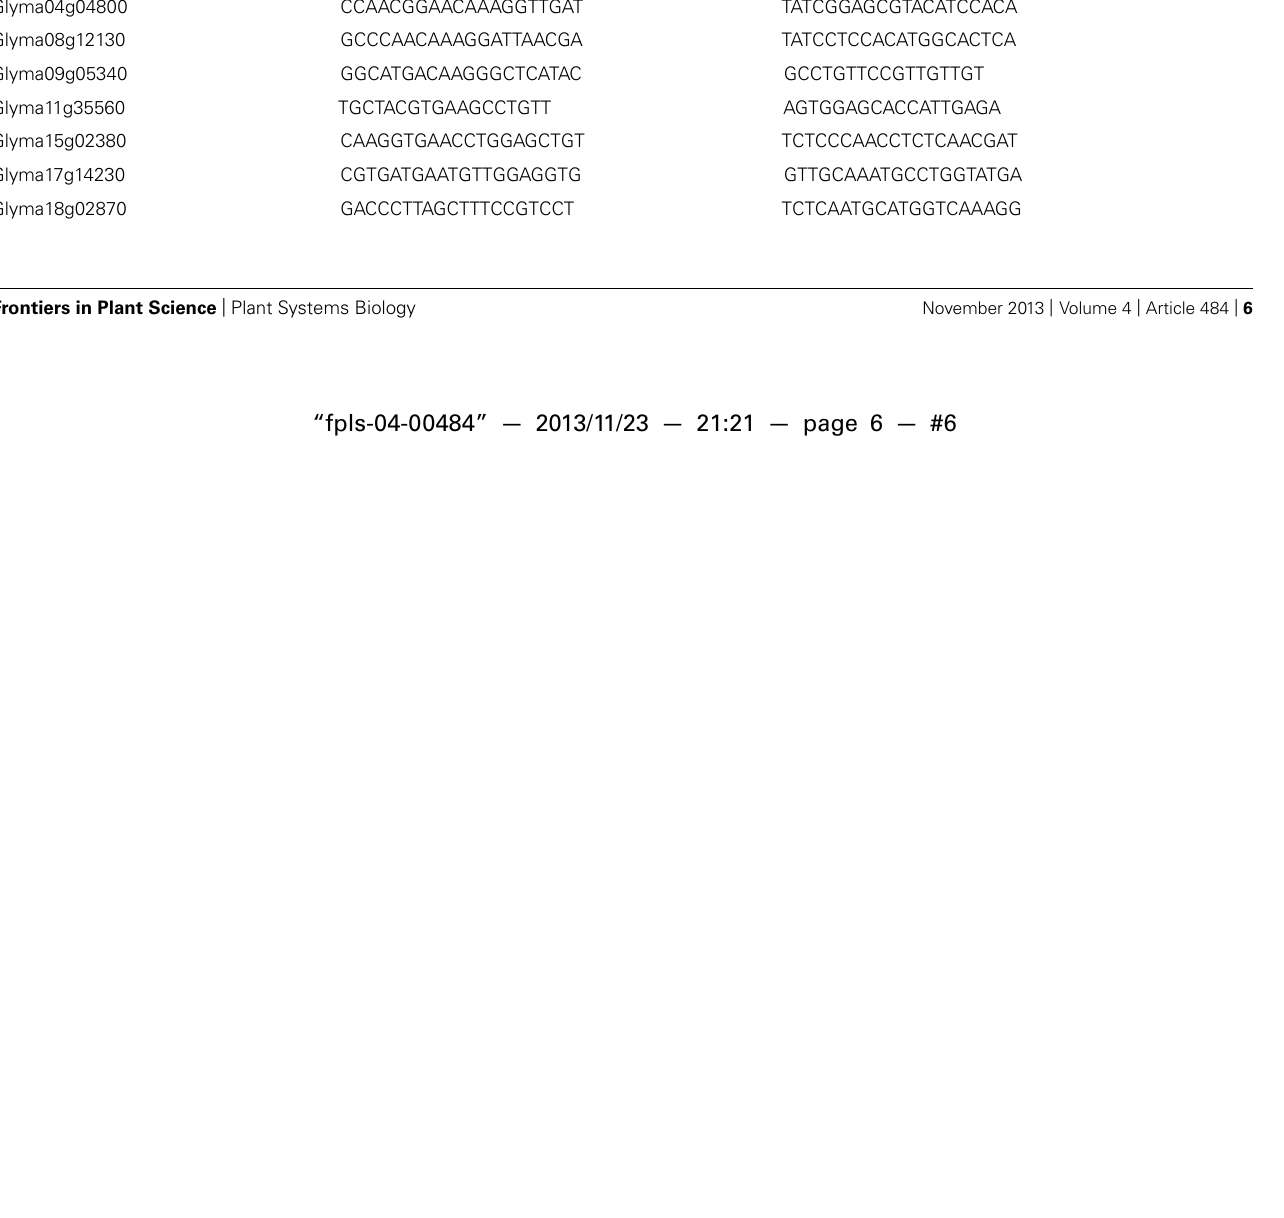
Table 1 | qRT-PCR primers. Soybean gene